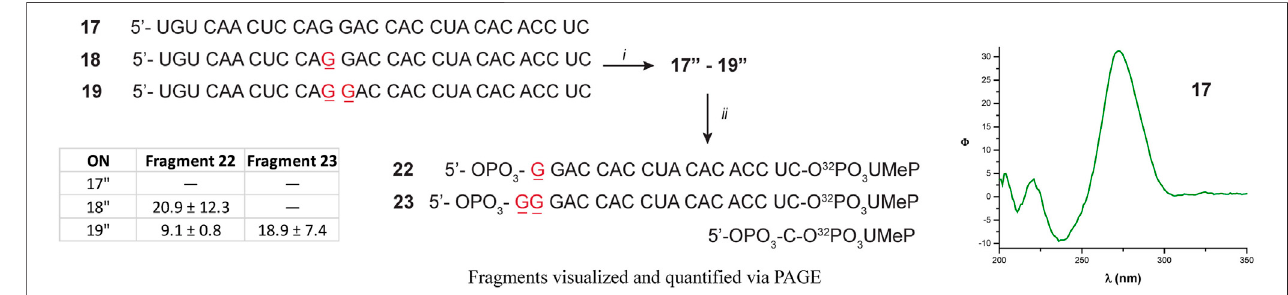
Frontiers in Molecular Biosciences |